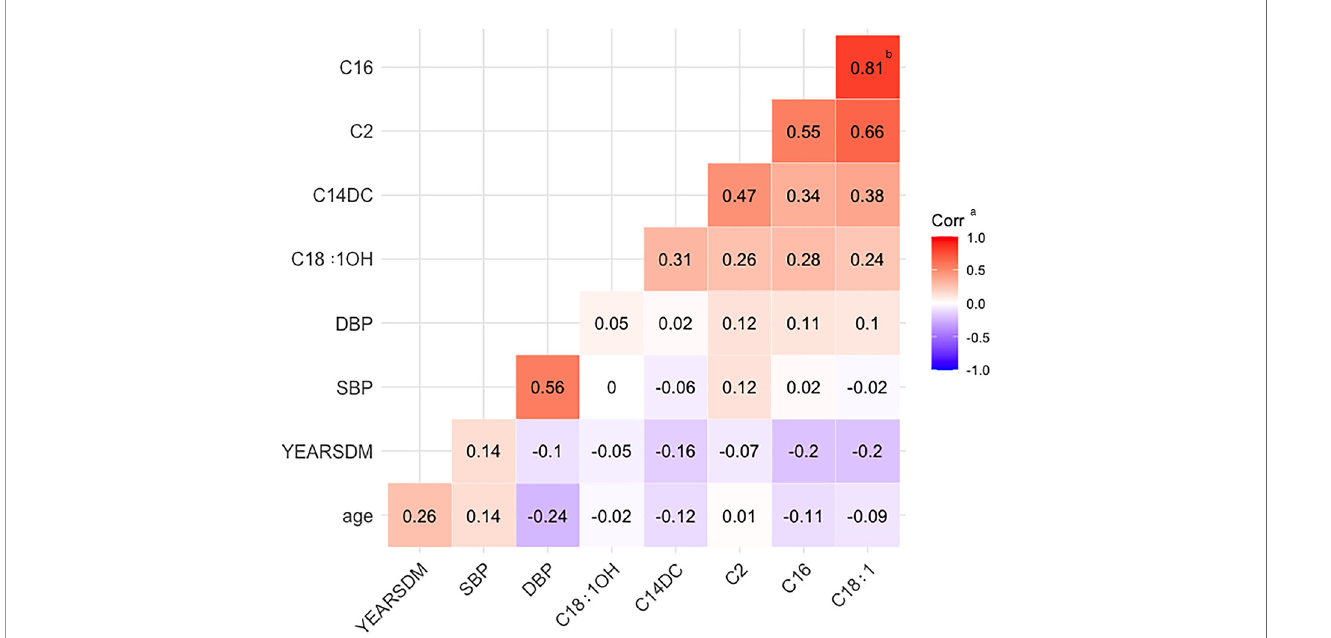
FIGURE 1 | Heat map of correlation. YEARSDM, diabetes duration; SBP, systolic blood pressure; DBP, diastolic blood pressure; C18:1OH, 3-hydroxy- octadecylcarnitine; C14DC, tetradecanoyldiacylcarnitine; C2, acetylcarnitine; C16, palmitoylcarnitine; C18:1, octacarbonylcarnitine. a Corr, the correlation coef fi cient r, red indicates positive correlation, blue indicates negative correlation, r > 0.8 indicates that the two variables correlate. b The two positively correlated variables, C16 and C18:1, had a correlation coef fi cient of 0.81.